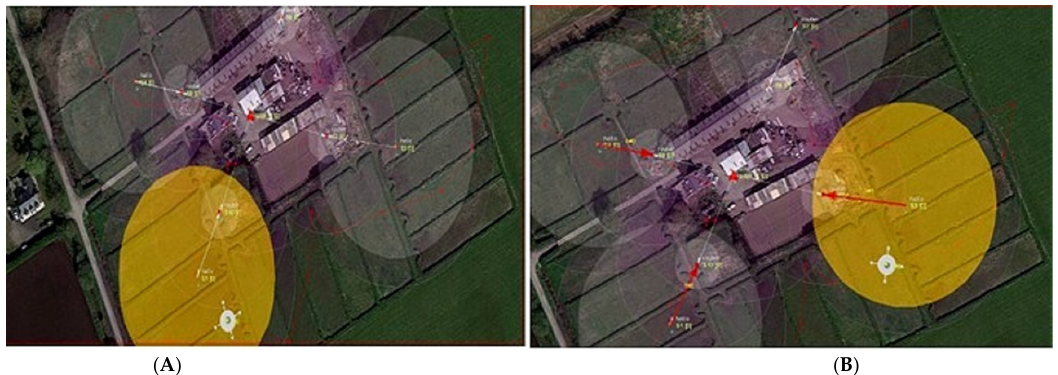
Figure 13. ( A , B ) The drone movement is visible in different clusters as the multi-hop environment increased the sensing range. Appl. Sci. 2023 , 13 , x FOR PEER REVIEW